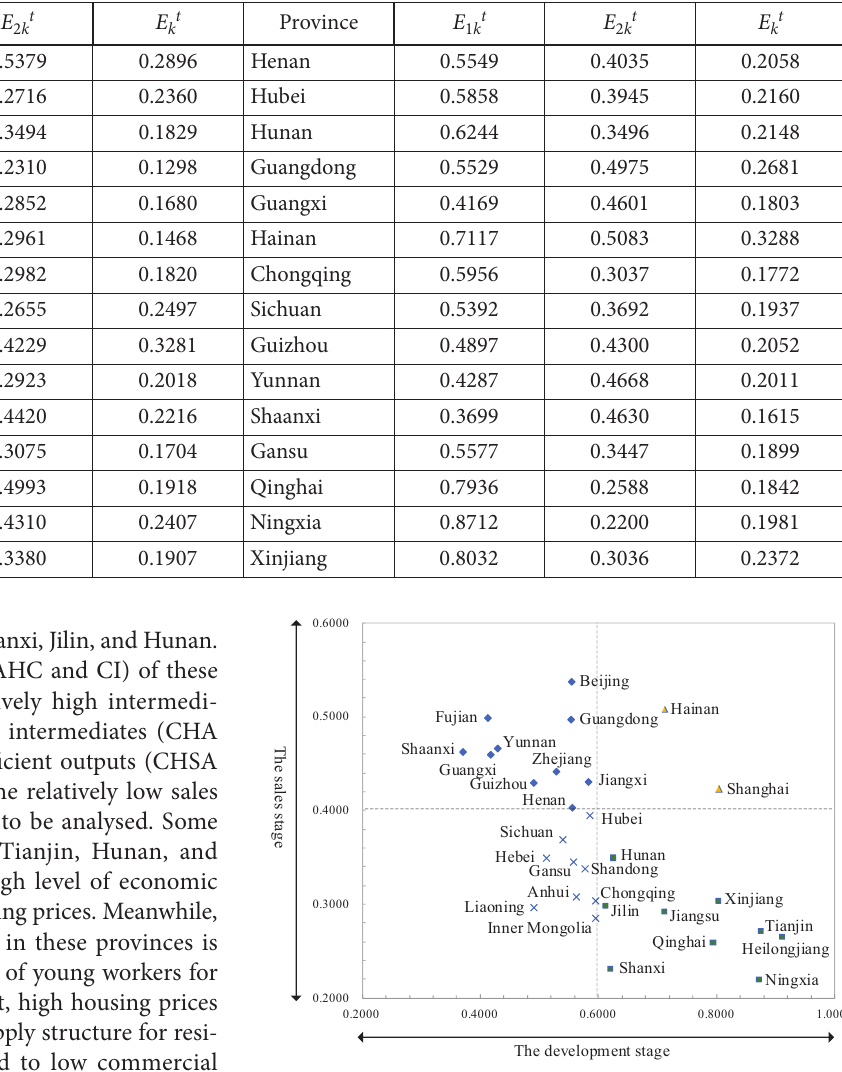
Figure 6. The chart of the provincial multi-period two-stage efficiency and its